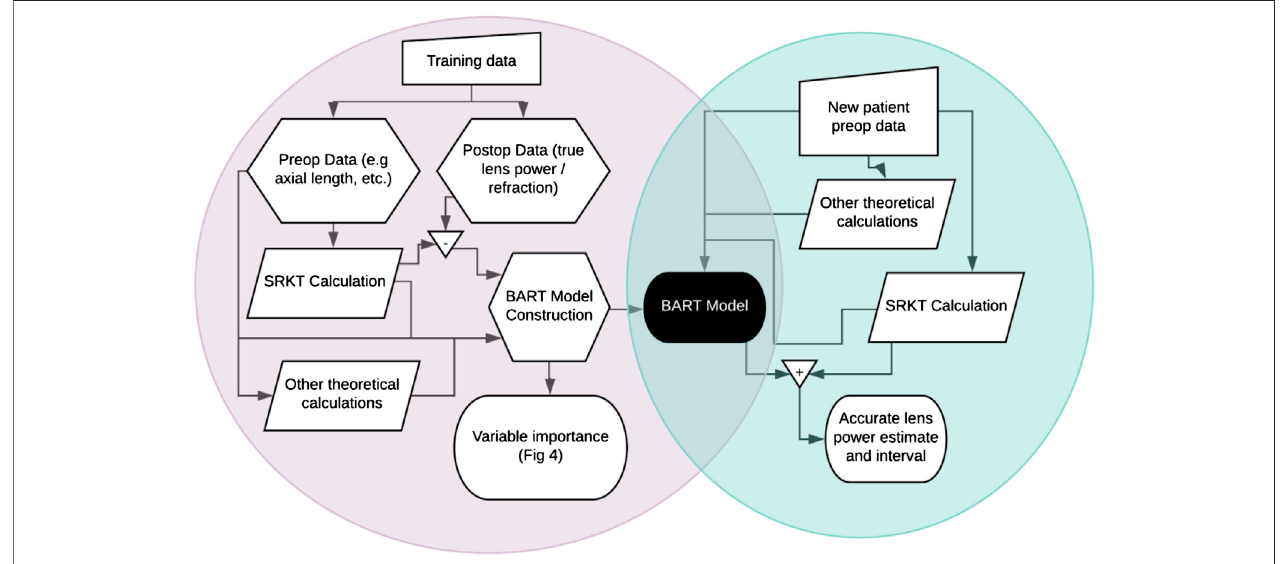
FIGURE 1 | Flowchart of (A) BART model creation in the left circle and (B) patient lens power prediction in the right circle. Training data enables the creation of a Bayesian Additive Regression Trees (BART) model which can then be used to predict lens power for future patients.